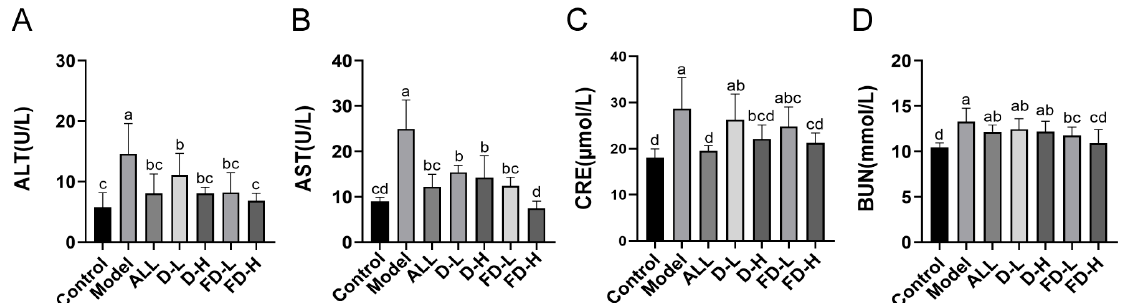
Figure 3. Effect of fermented dandelion on liver and kidney function in mice with HUA. ( A ) Serum ALT level. ( B ) Serum AST level. ( C ) Serum CRE level. ( D ) Serum BUN level. The data are expressed as mean ± SD (n = 8). Different lowercase letters indicate statistically significant differences ( p < 0.05) between the groups. ALL, allopurinol; D-L, dandelion low dose group; D-H, dandelion high dose group; FD-L, low dose group of LAFD; FD-H, high dose group of LAFD.